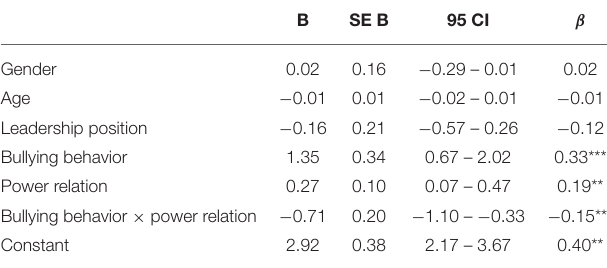
TABLE 2 | Exposure to bullying behavior and power relation as predictors of intent to leave (main and interactive